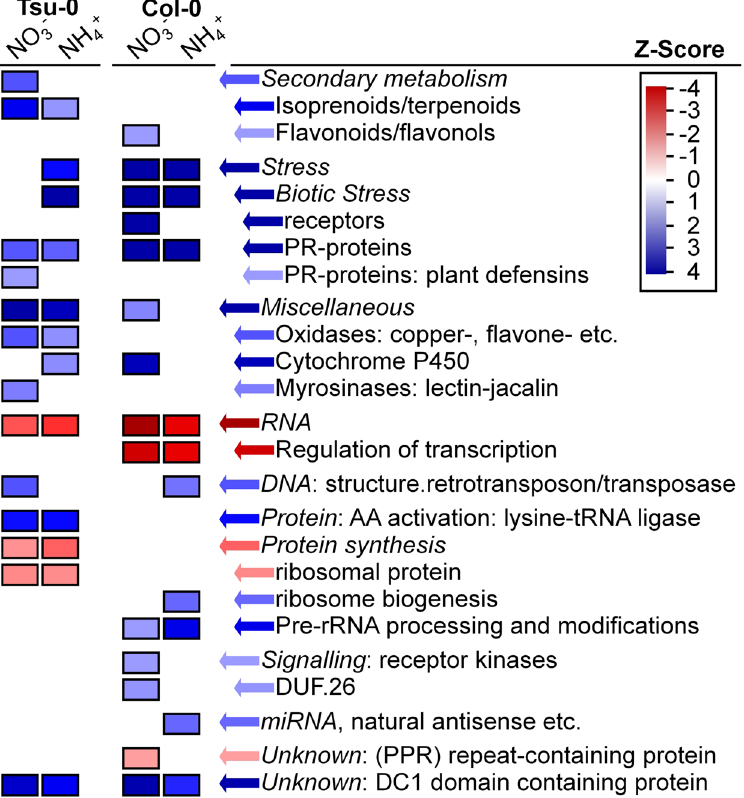
Figure 5. Overrepresentation analysis of Col-0 and Tsu-0 N-form-specific root transcriptomes. Overrepresented MapMan bins of 35 days old Col-0 or Tsu-0 plants grown on nitrate or ammonium as sole nitrogen source for five days. Comparisons were taken between both accessions grown with the same N-form in the nutrient solution (e.g. Col-0 NH 4 + vs. Tsu-0 NH 4 + ). Conducted with Fisher’s exact test and Benjamini- Hochberg corrected p-values, which were Z transformed (e.g. p = 0.05 ≜ Z =